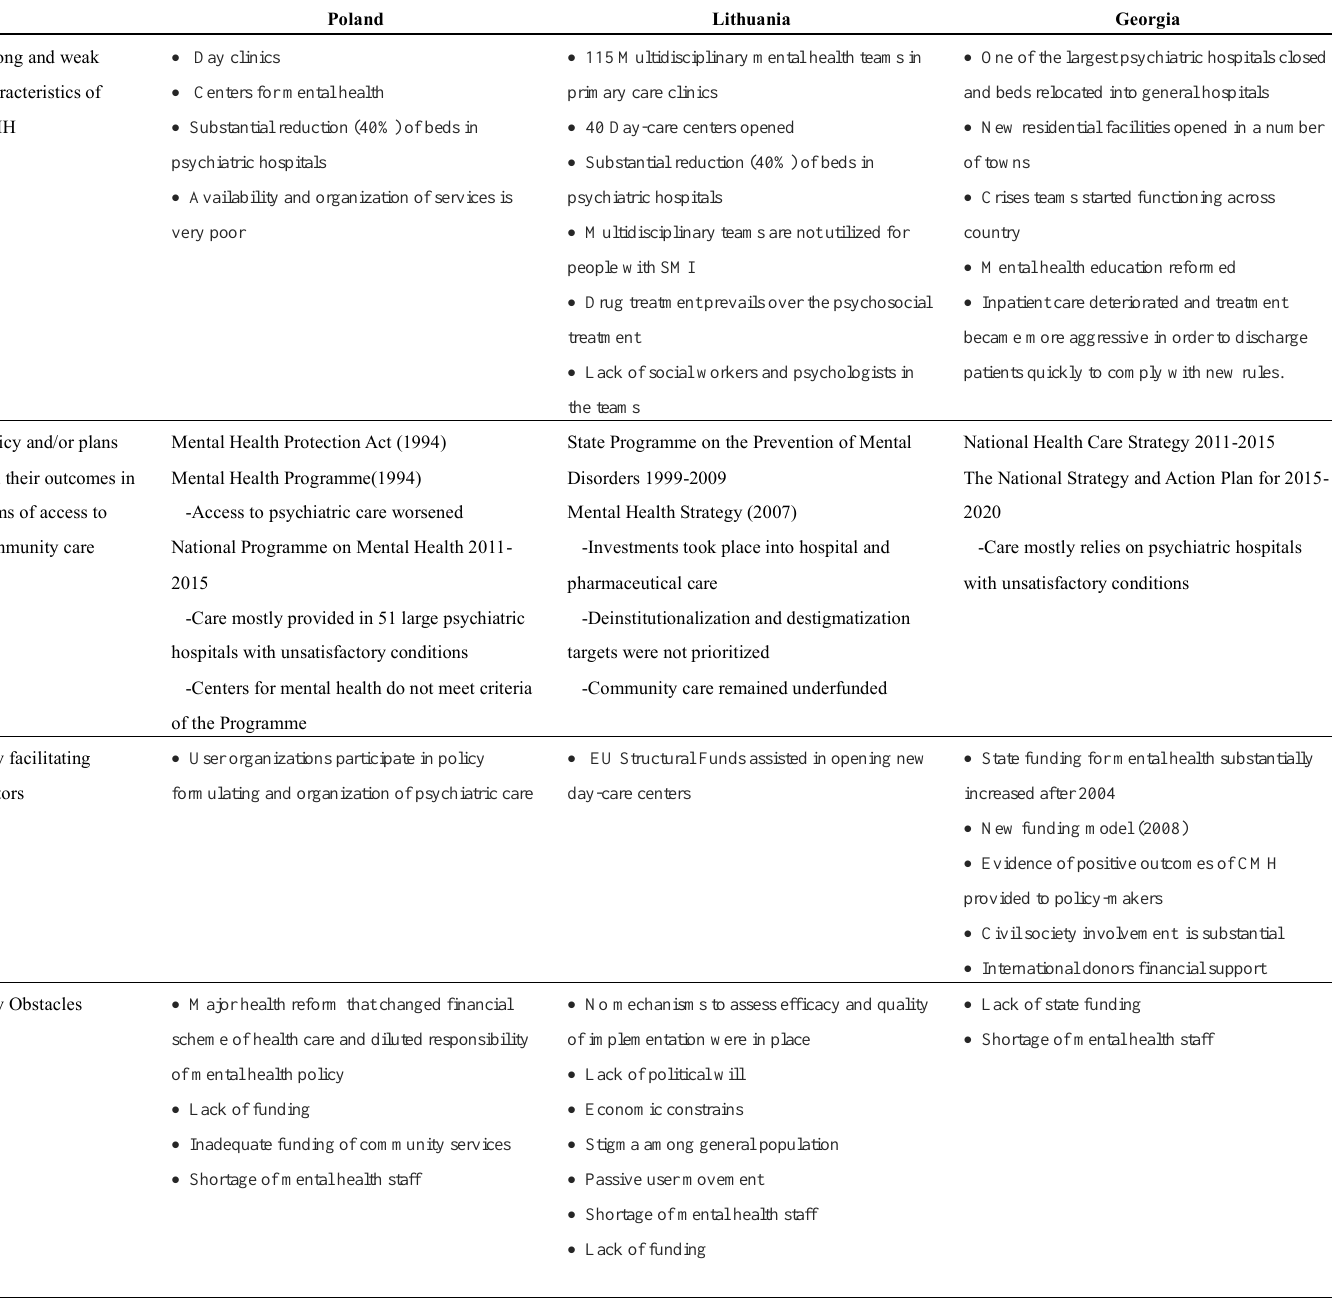
Table 1. Community mental health development in Poland, Lithuania, and